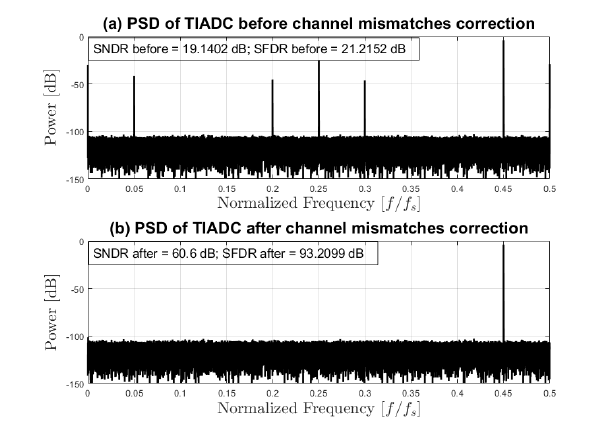
Figure 6. Output spectrum of four-channel TIADC before and after calibration.